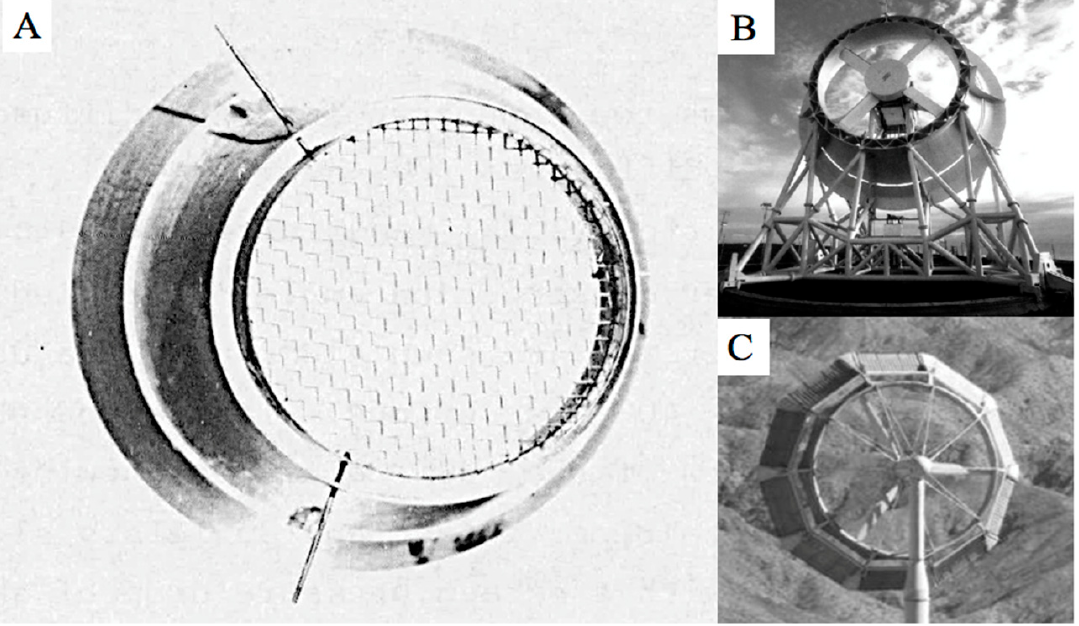
Figure 2. ( A ) Grumman Double Annulus, Boundary Layer Control, 30 Diffuser Augmented Wind Turbines (DAWTs) with wire mesh installed for wind tunnel testing, [16]; ( B ) Vortec 7 [17]; ( C ) Flodesign / Ogin MEWT [18].